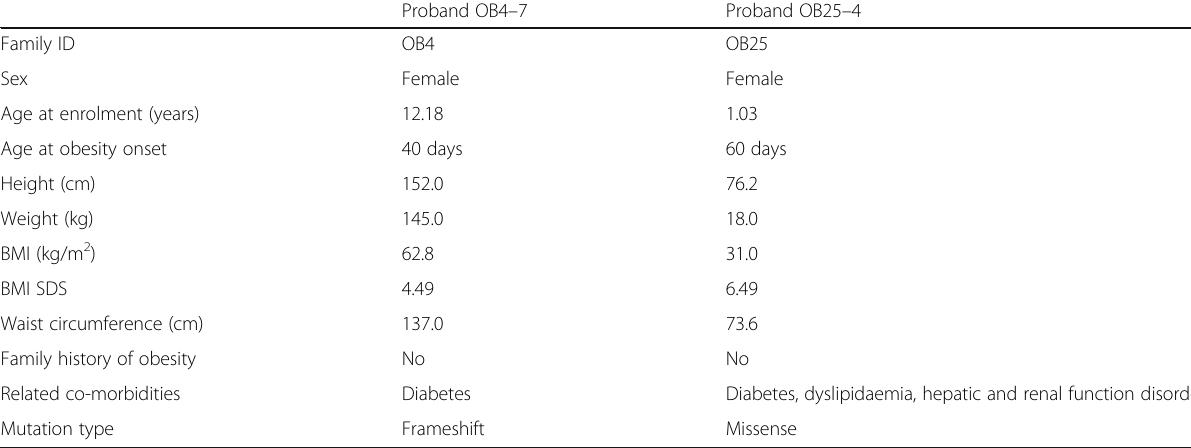
Table 1 Clinical characteristics of probands with homozygous LEPR mutations Proband OB4 – 7